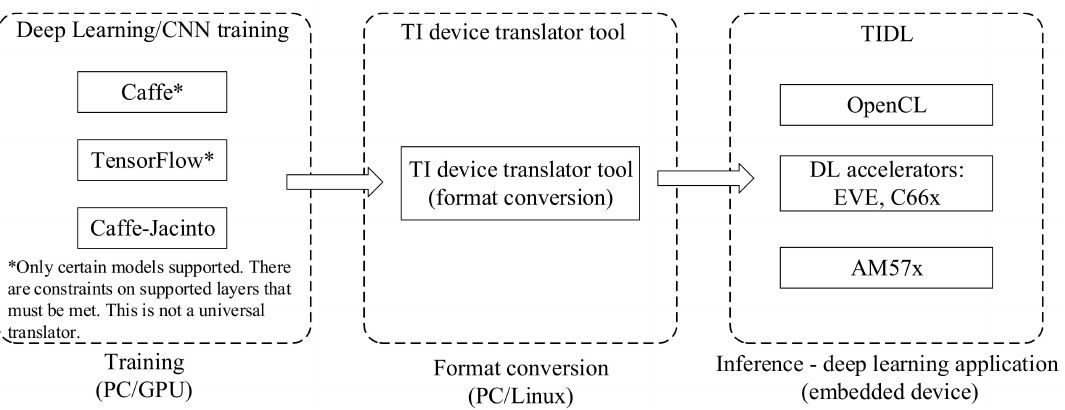
Figure 9. TI Deep Learning (TIDL) development flow. Deep learning consists of two stages: training at the development stage and inference at the deployment stage. Training involves designing the neural network model, running training data through the network to tune the model parameters. Inference takes the pretrained model including parameters, applies to new input, and produces output. Once the network is trained, the TIDL converter tool can be used to translate the network and parameters to TIDL.